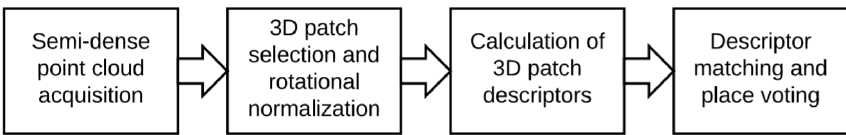
Figure 32. The pipeline of [85] place recognition pipeline in semi-dense maps.